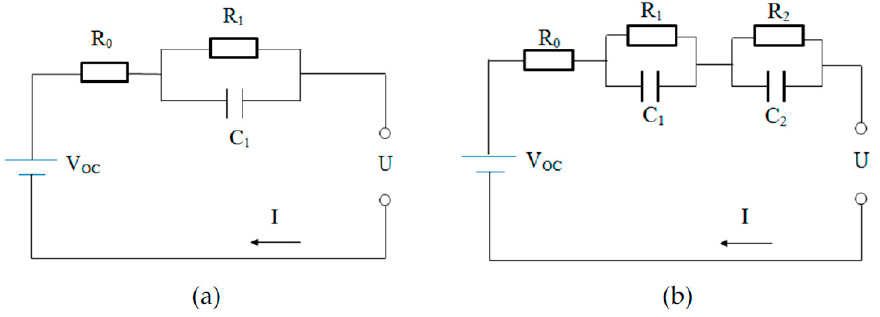
Figure 1. The first-order resistor–capacitor (RC) ( a ) and second-order RC ( b ) equivalent circuit models.